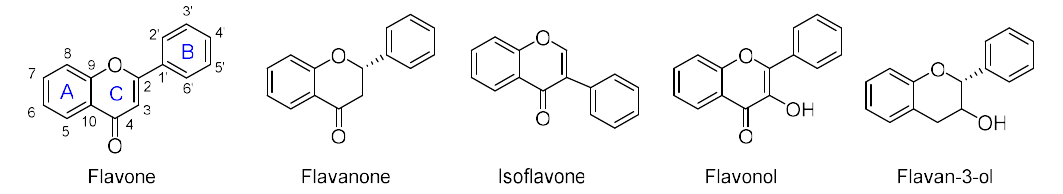
Figure 1. Basic structures of major flavonoid subclasses.